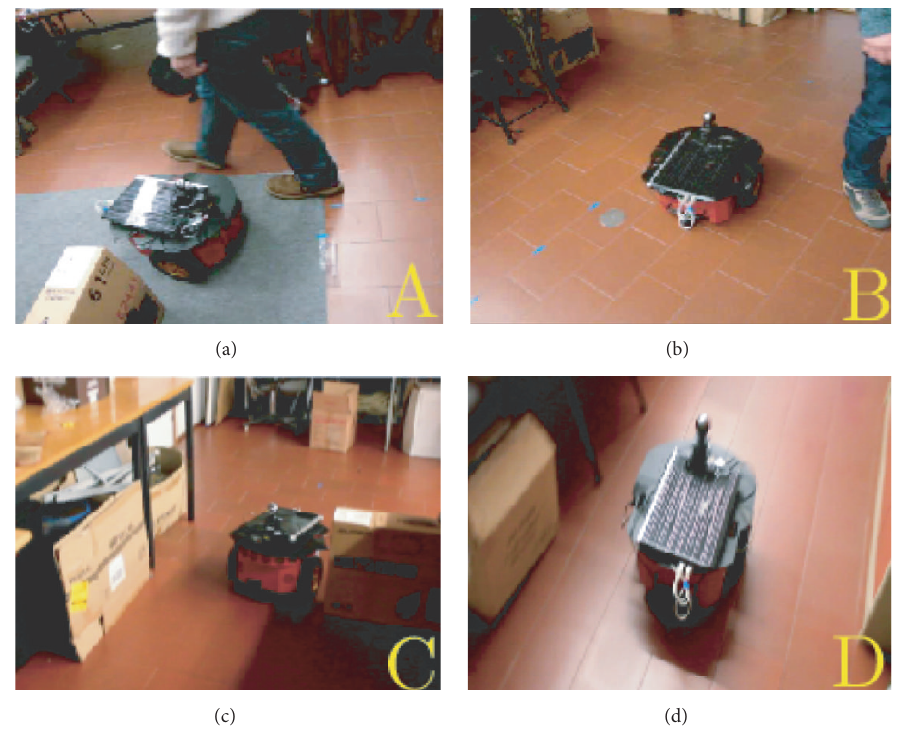
Figure 10: Snapshots of the robot performing the mission of experiment 1